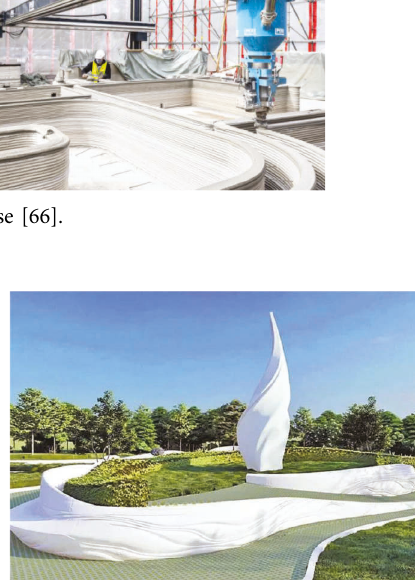
Figure 34: 3D printing of concrete landscape square